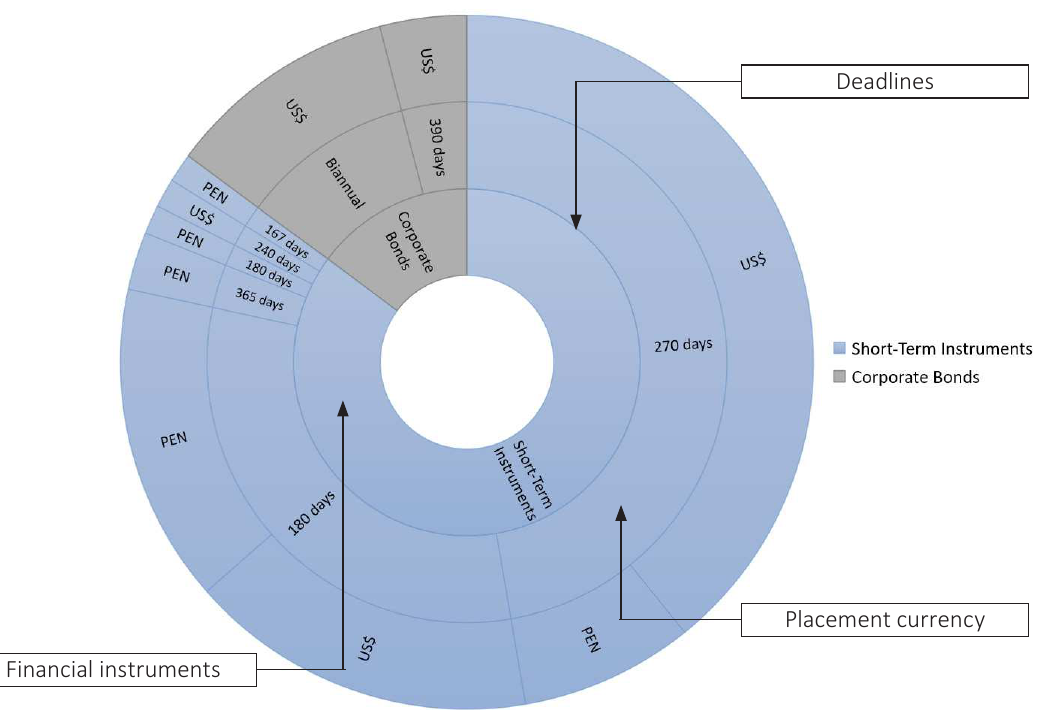
Figure 1. Financial instruments, terms, and placement currencies